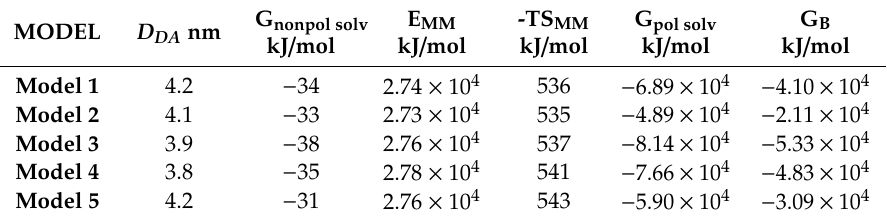
Table 1. Binding free energy, ∆ G B , and its components for the five best DBD-miR4749 interaction models. ∆ G nonpol solv represents the nonpolar contribution to the solvation term, ∆ E MM , the internal energy, -T ∆ S MM , the entropic term, and finally the ∆ G pol solv is the electrostatic contribution to the solvation term. D DA is the distances between the 5 (cid:48) end of miR4749 and the aromatic ring center of the lateral chain of Trp146. G nonpol solv E MM -TS MM D DA nm kJ / mol kJ / mol kJ /